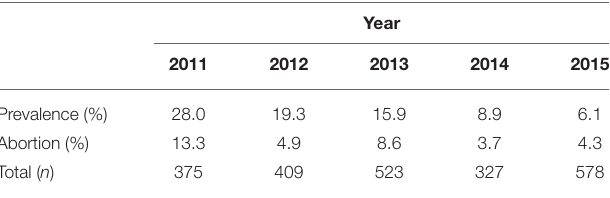
TABLE 2 | Descriptive data about prevalence and N. caninum -related abortion in dairy heifers after by selective culling and artificial insemination (AI) using Hereford semen on seropositive dairy